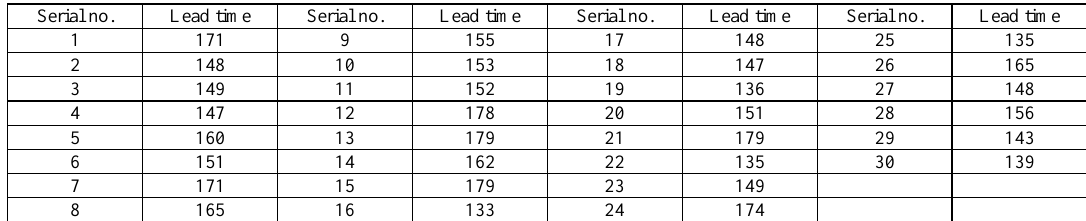
Table 2. Lead times of 30 contracts of the case